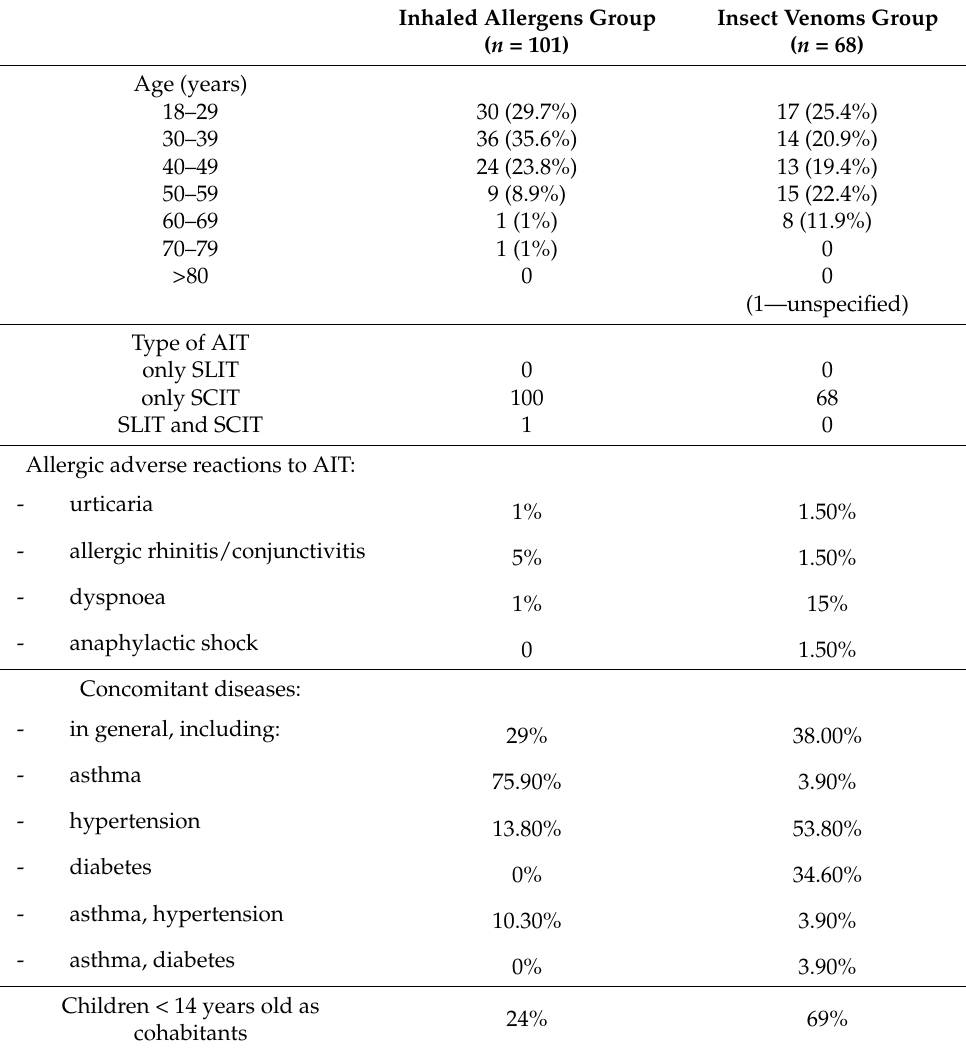
Table 1. Baseline characteristics of the patients.